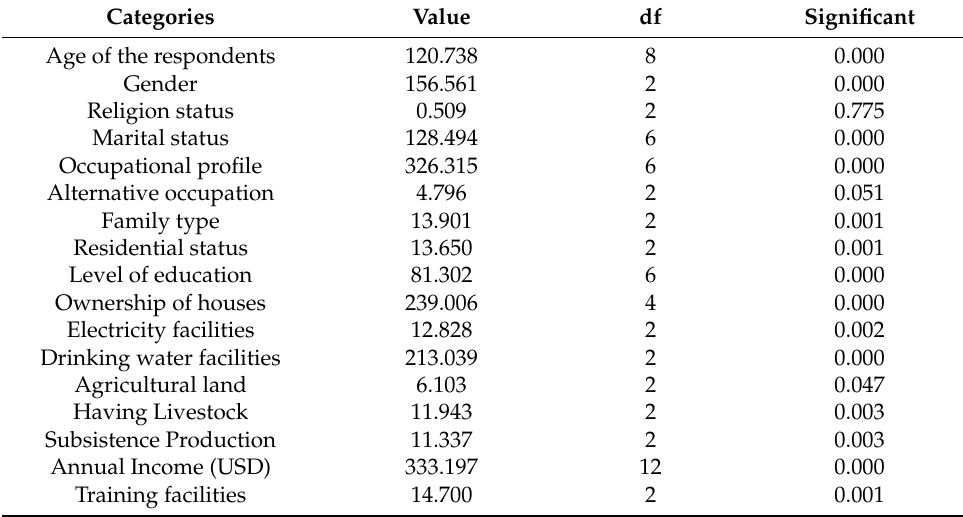
Table 7. Likelihood ratio test between different categorical